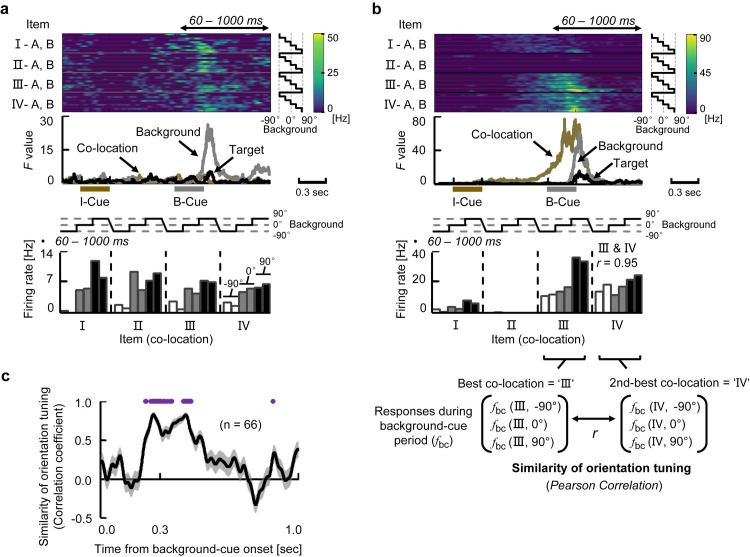
Convergence of the retrieved memory and incoming perception.(a) Example neuron signaling background effect. (Top) Each row contains an SDF for each combination of I- and B-Cues. (Middle) Time courses of F values. Brown bar, presentation of the I-Cue. Gray bar, presentation of the B-Cue. (Bottom) Mean discharge rate for each combination of I- and B-Cues during 60–1,000 milliseconds after B-Cue onset. White, gray, and black bars indicate −90°, 0°, and 90° orientations of background cue, respectively. Two bars with the same grayscale indicate the co-location items (e.g., left bar, I-A; right bar, I-B). (b) Example neuron signaling background and co-location effects in a “convergent” manner. Same format as Fig 4A. r, Pearson correlation coefficient between the orientation tunings (responses to −90°, 0°, and 90° during the B-Cue period) for “best co-location” (III) and for “second-best co-location” (IV). (c) Time course of similarity of orientation tuning r(t). Line and shading, means and SEMs of the similarity of the orientation tunings for co-location-selective neurons. Purple line, time duration in which the similarity was significantly positive (P < 0.01, n = 66, Wilcoxon’s signed-rank test for each time step, 2-tailed). Source data are available in S1 Data. B-Cue, background cue; I-Cue, item cue; SDF, spike density function.